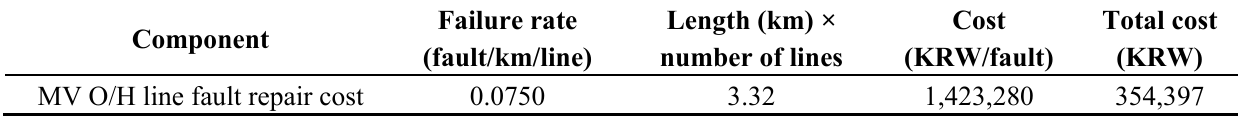
Table 8. Fault repair costs of MVAC.